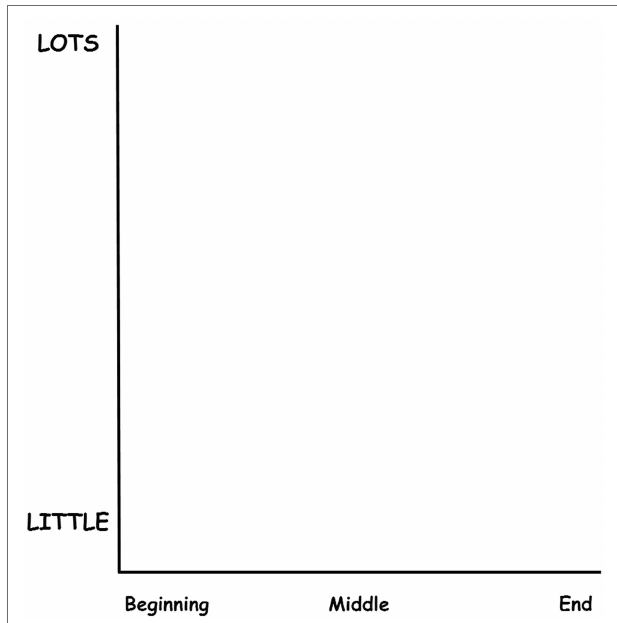
FIGURE 2 | Adapted AES used for the testing phase. The AES has been adapted to include the time point anchors of ‘beginning’, ‘middle’ and ‘end’ along the x-axis, and the intensity anchors of ‘lots’ and ‘little’ along the